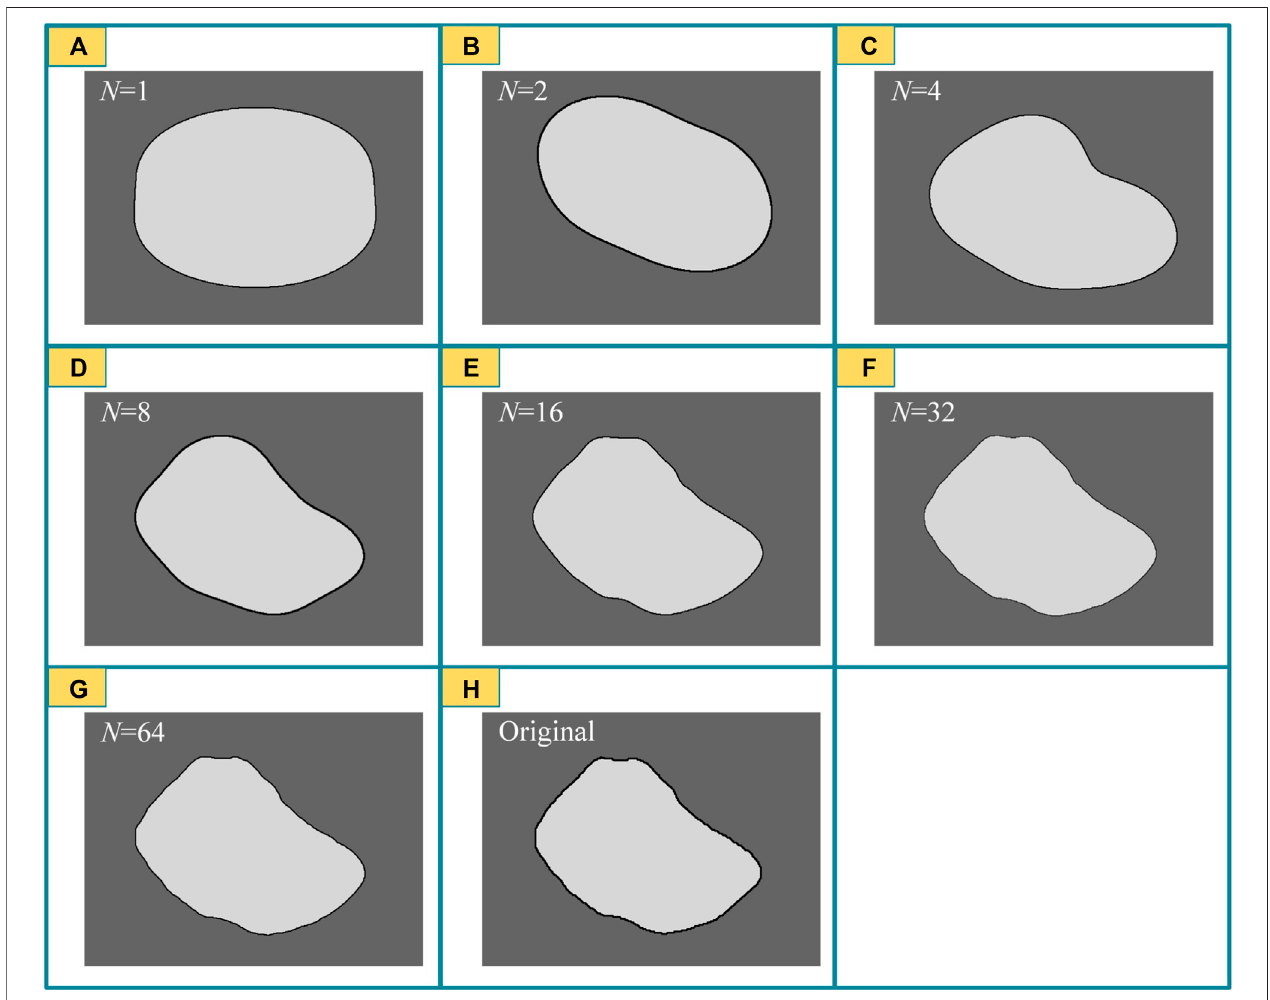
FIGURE5| Comparison betweenreconstructedpores based onIDFT with different numbers ofharmonics N = (A) 1; (B) 2; (C) 4; (D) 8; (E) 16; (F) 32; (G) 64;and (H) natural extracted (original) pores.